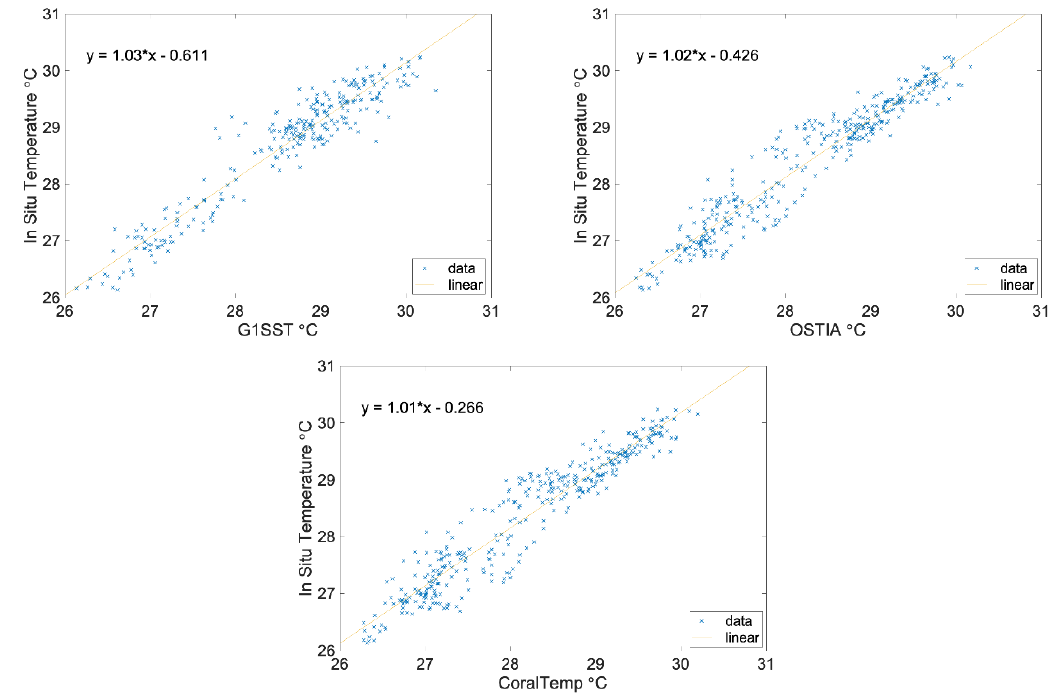
Figure 9. Scatter plots with linear regression of the averaged in situ temperature against the different three different remote sensing SST datasets for San Cristobal.